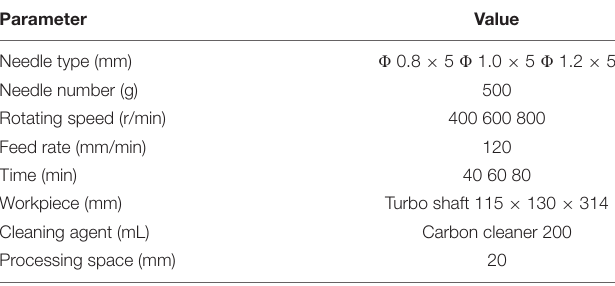
TABLE 1 | Experiment parameters.